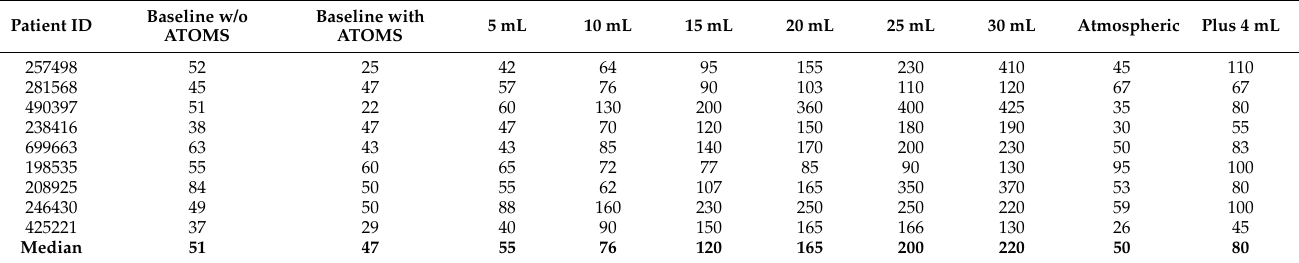
The regression analyses showed significant direct relationships between cushion vol- umes and intraurethral pressure (beta coefficient = 0.072 cm H2O/mL, p = 0.000). Intraure- thral pressures increased mildly to moderately with filling under 15 mL (73 ± 22.7 cm H2O) but above 20 mL, there was a wide variability in the pressure increment (233 ± 108.9 cm H2O) (Figure 3).